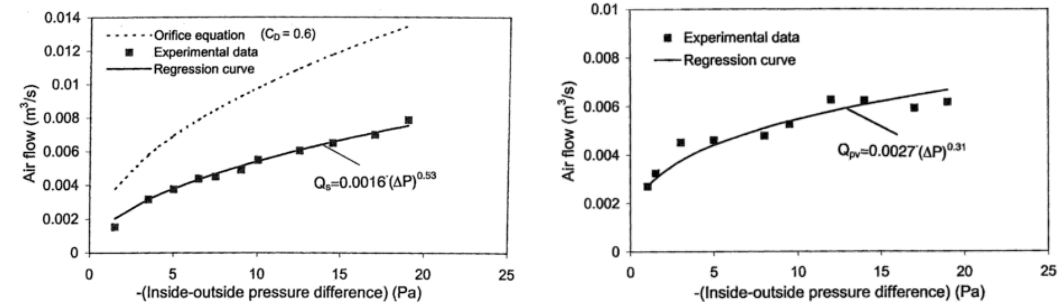
Figure 7. Air flow through slot- ( left ) and pressure-controlled ( right ) Trickle Vents [45].